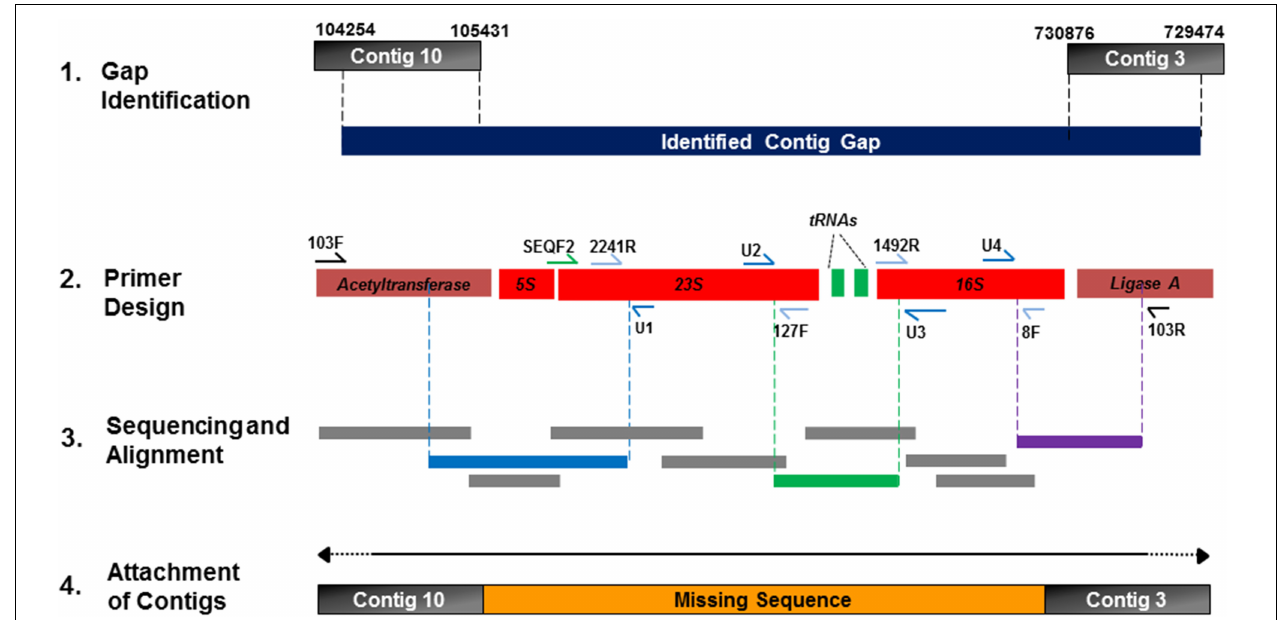
FIGURE 5 | Innovative primer walking strategy for sequencing of repetitive rRNA operons. Putative gaps between contigs were identified by the contig-reordering tool within Mauve against other completely sequenced P. polymyxa strains. Primers U1, U2, U3, and U4 were designed to amplify the rRNA operon as depicted, allowing for rapid